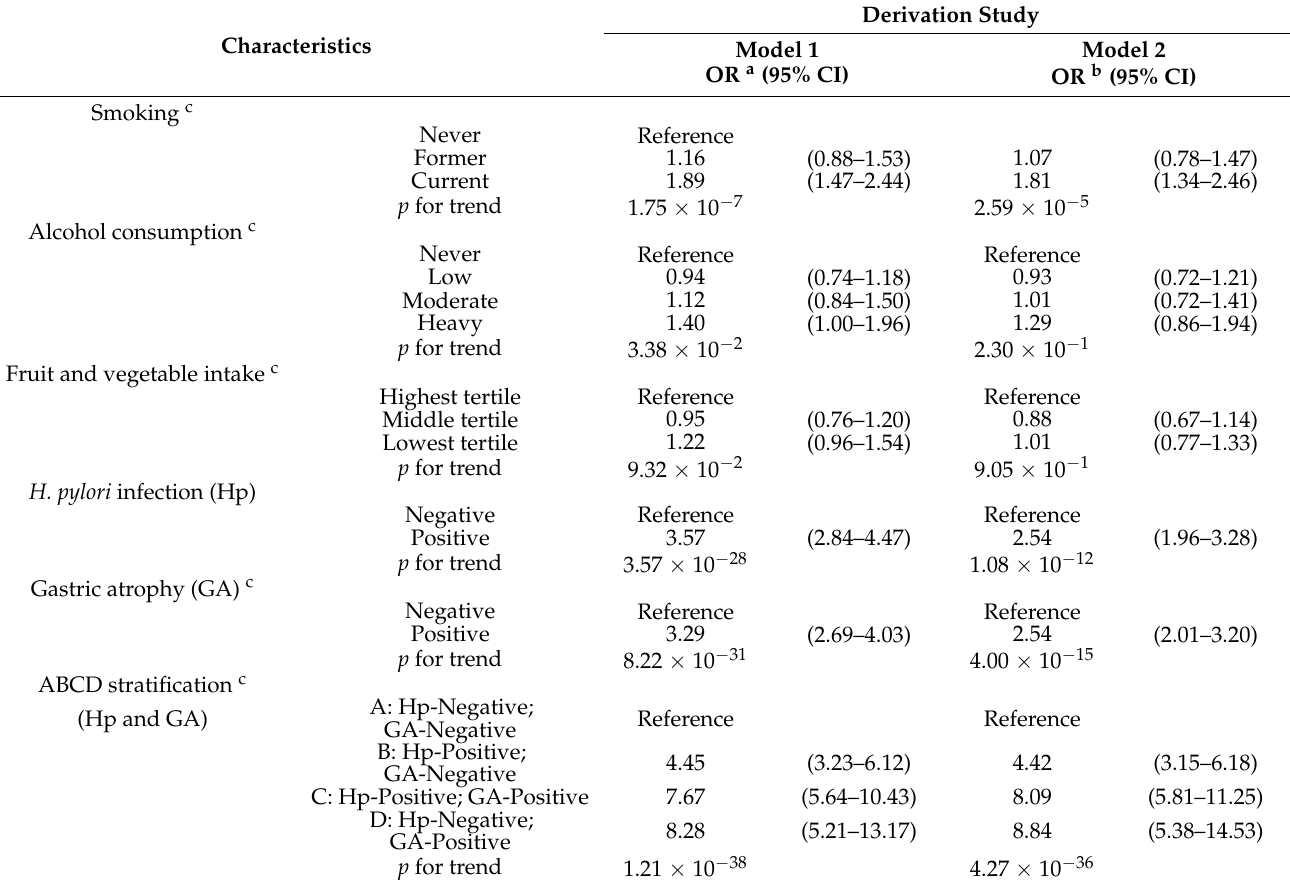
Table 2. Associations of epidemiological and clinical risk factors in stomach cancer (derivation